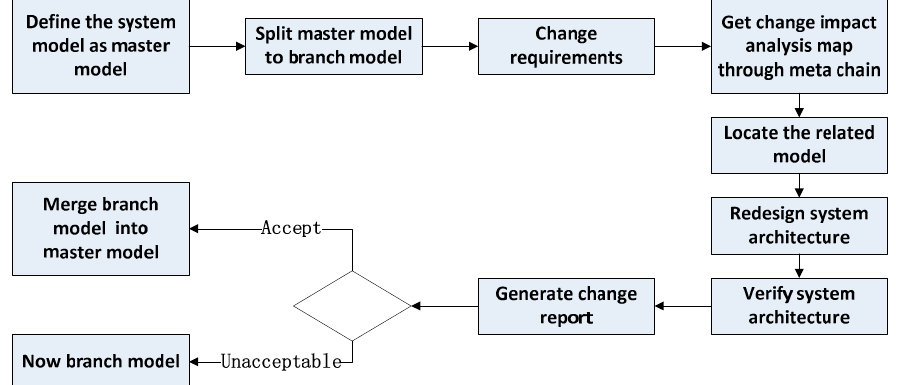
Figure 12. Requirement change impact analysis process.